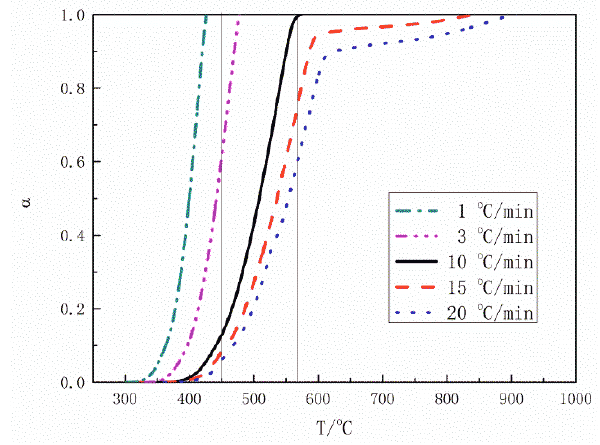
Figure 4. Reaction fraction curves of pure hematite particles reduced by pure hydrogen.